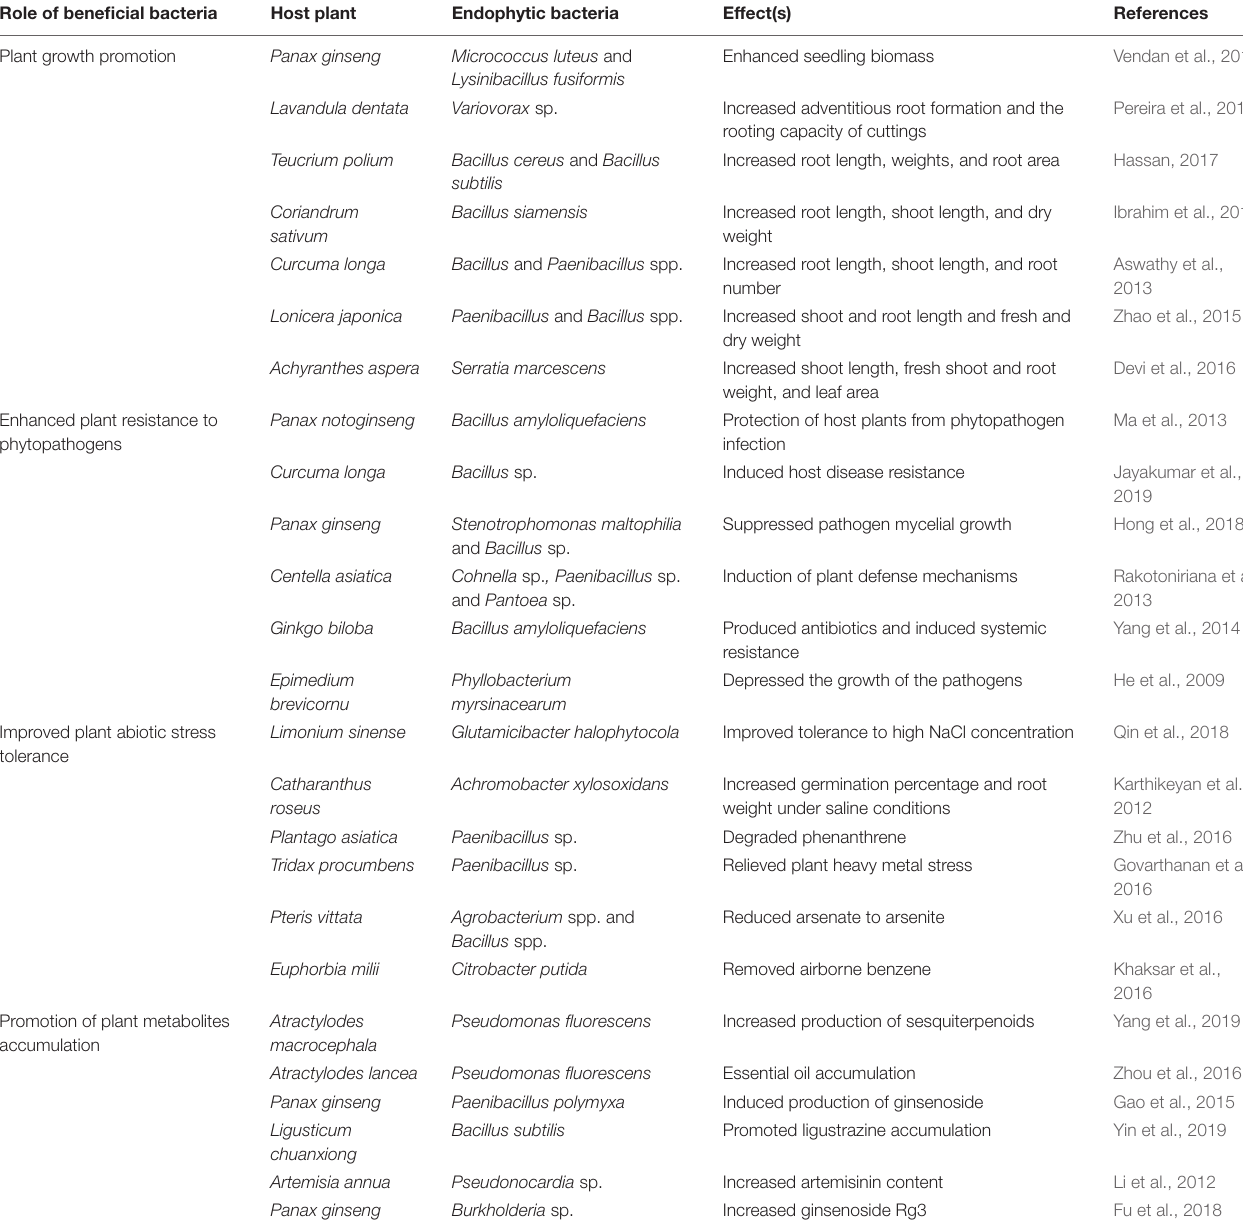
TABLE 2 | Beneficial relationships between endophytic bacteria and host